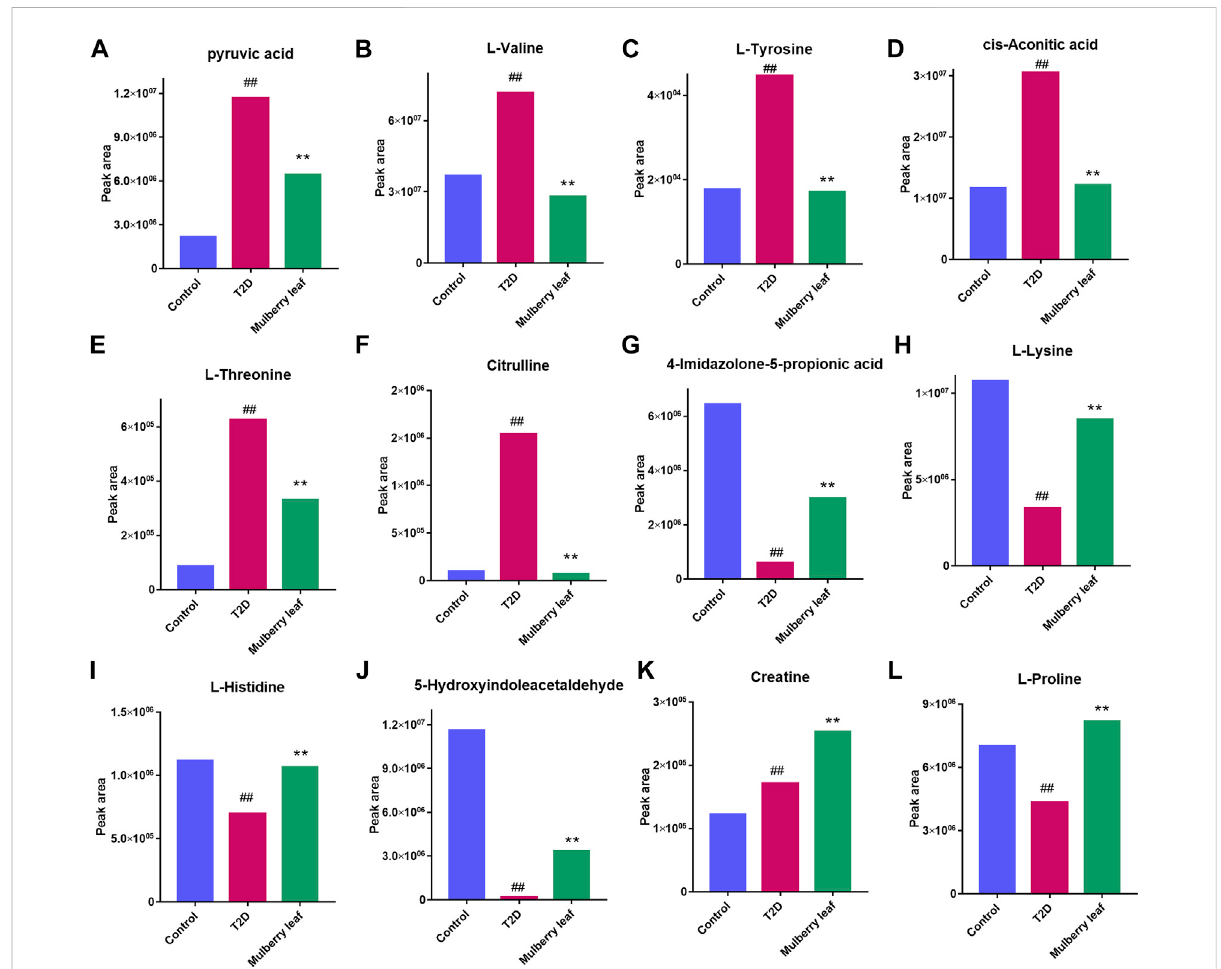
FIGURE 8 Potential metabolite changes in the serum of T2D rats with the ML treatment (A) Pyruvic acid (B) L -valine (C) L -tyrosine (D) Cis-aconitic acid